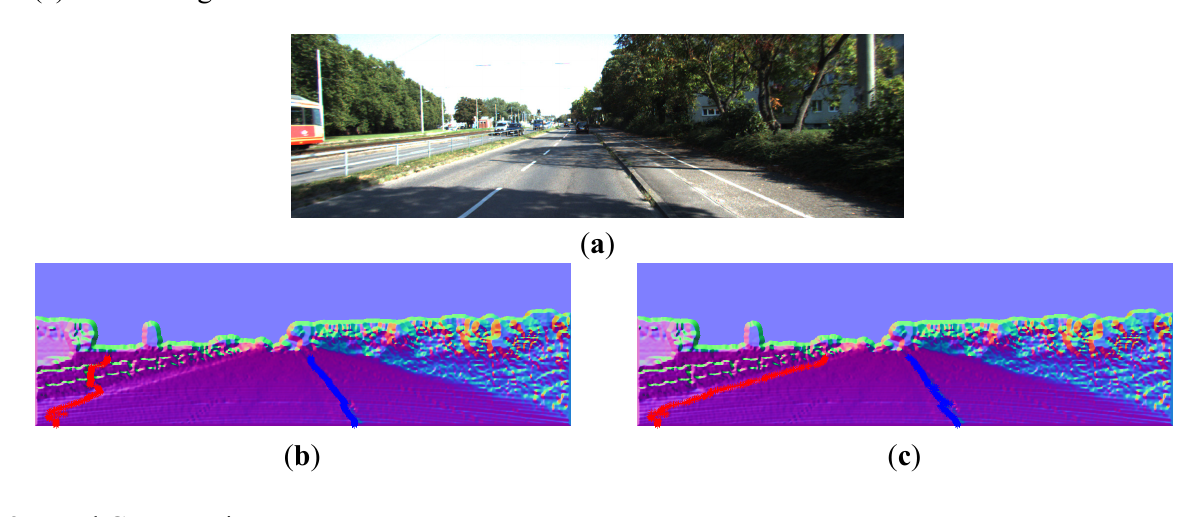
Figure 22. ( a ) Visual image. ( b ) The linking results with only position information. ( c ) Our linking